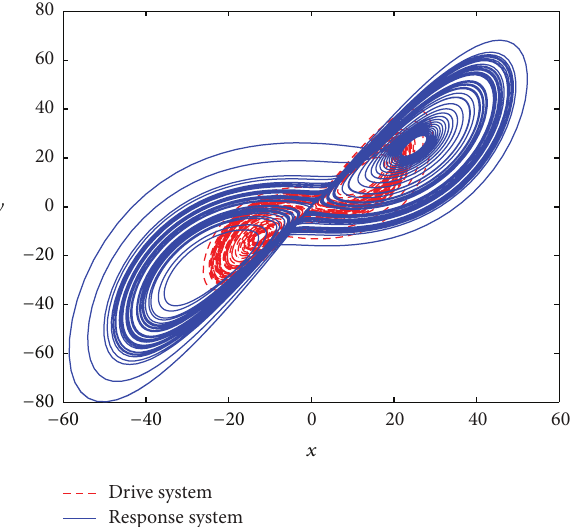
Figure 8: The phase plot of 𝑥 and 𝑦 plane with 𝛼 = −2 , 𝜏(𝑡) = 0 .